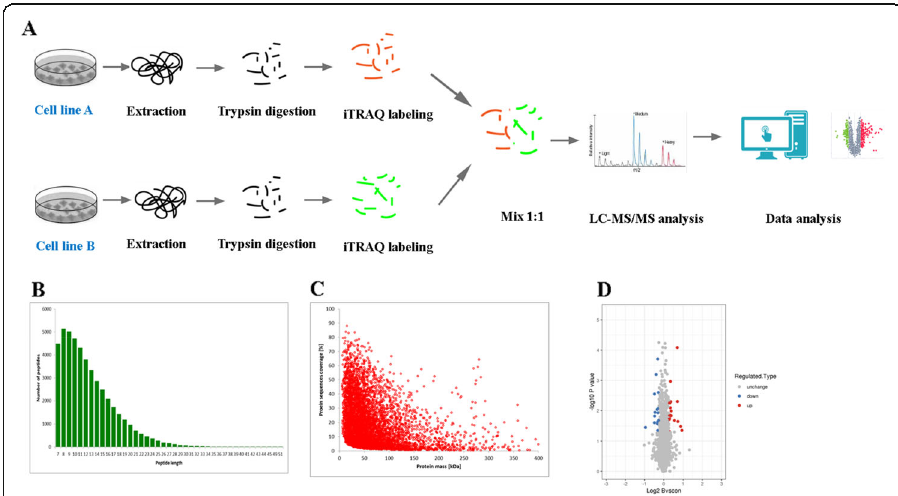
Fig. 2 Differentially expressed proteins were evaluated by iTRAQ proteomics. a Flow diagram of iTRAQ proteomics. b Length distribution of the peptides identified by mass spectrometry. c Relationship between protein molecular weight and coverage. d Volcano plot of differentially expressed